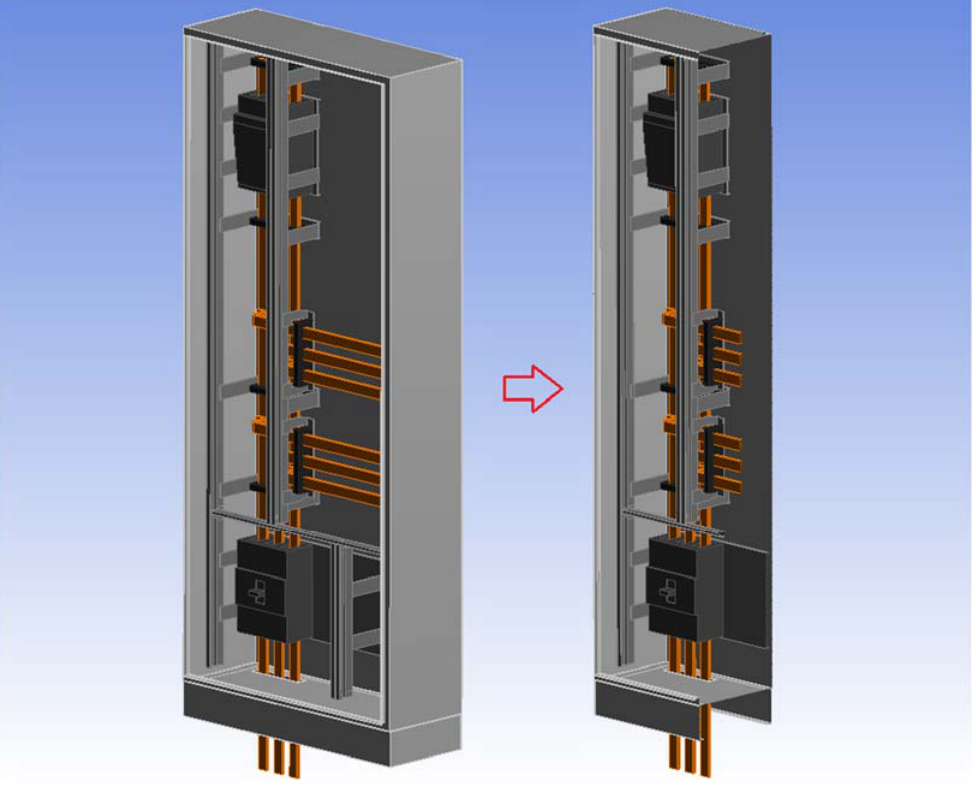
Figure 10. The switchgear cross-section necessary for calculations in Ansys Fluent 2D.